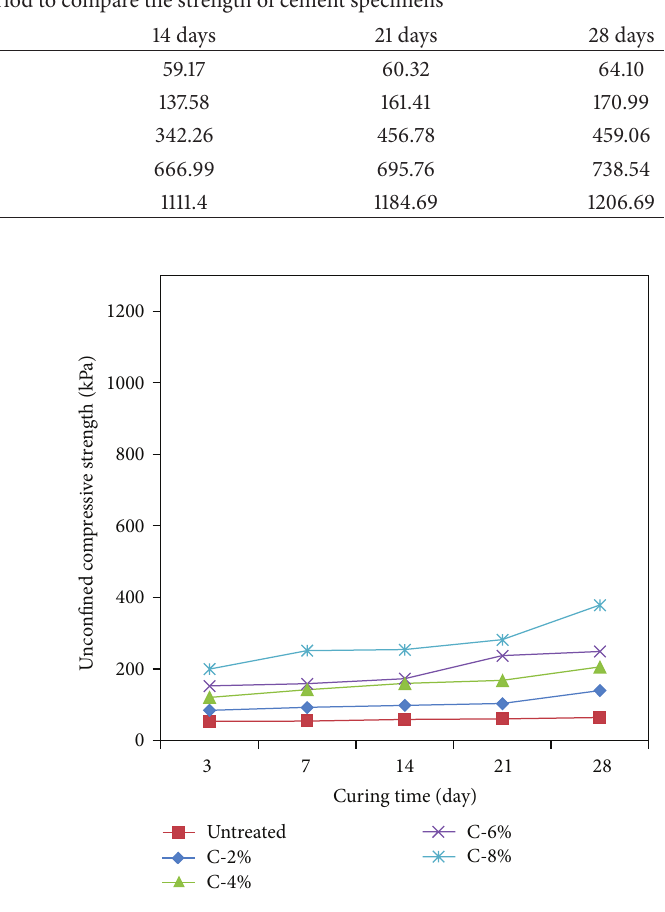
Figure 6: Curing period to compare the strength of calcium carbonate